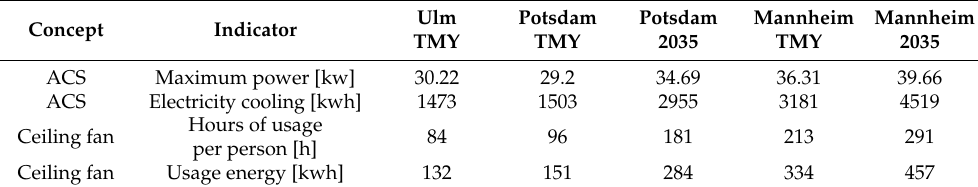
Table 13. Overview electricity usage for all locations and climatic scenarios.